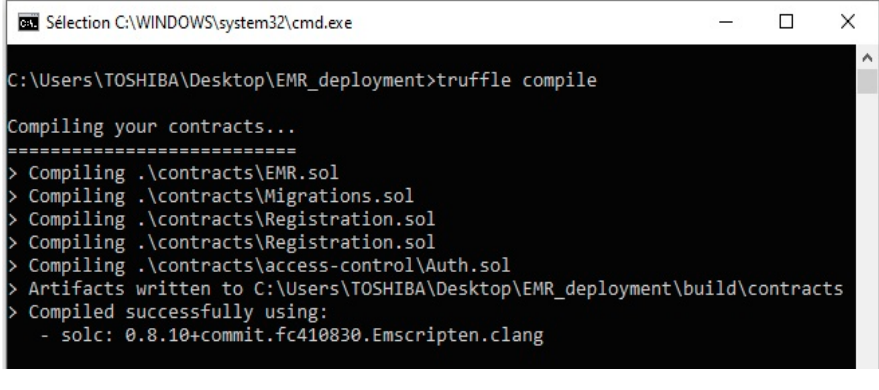
Figure 7. Compilation.